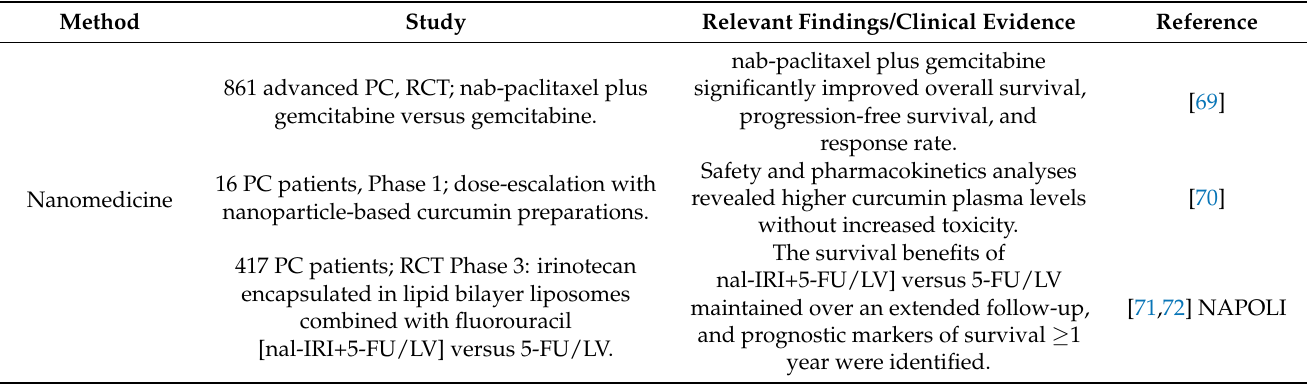
Table 2. Overview of published results from clinical